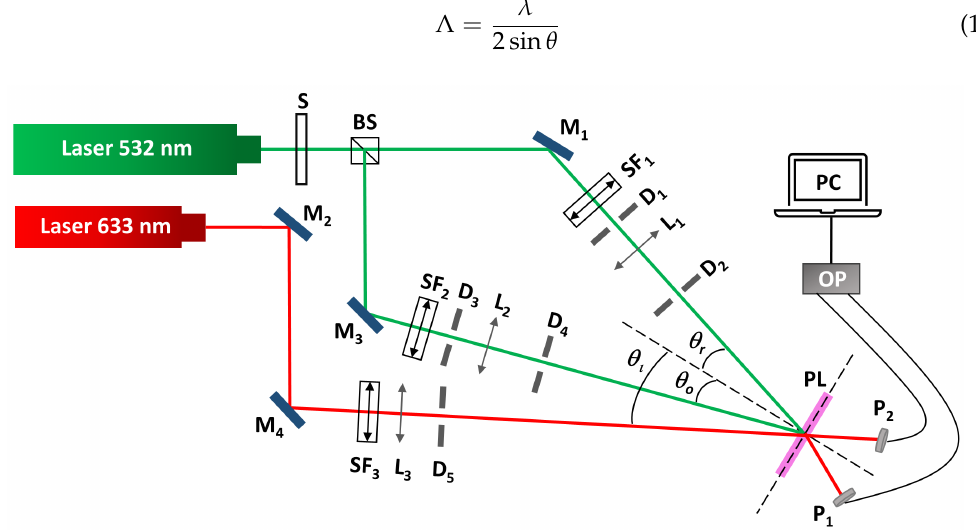
Figure 1. Holographic setup for transmission gratings. S: shutter; BS: beam splitter; SFi: spatial filters (microscope objective and pinhole); Mi: mirrors; Li: lens; Di: diaphragms; θ o and θ r: object and reference recording angle, θ i: incident reconstruction angle; PL: hydrogel matrix; Pi: photodetectors; OP: optical power meter; PC: data recorder.